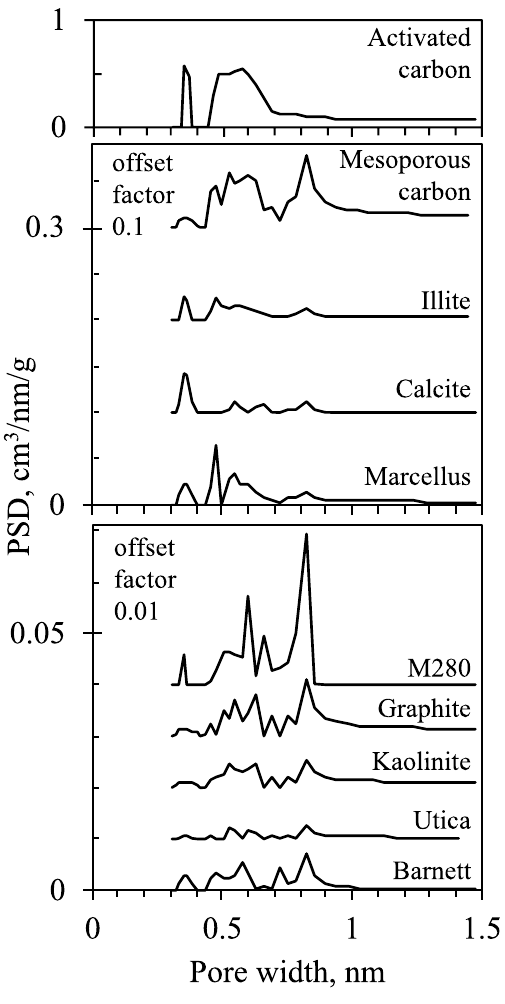
Figure 2. Pore size